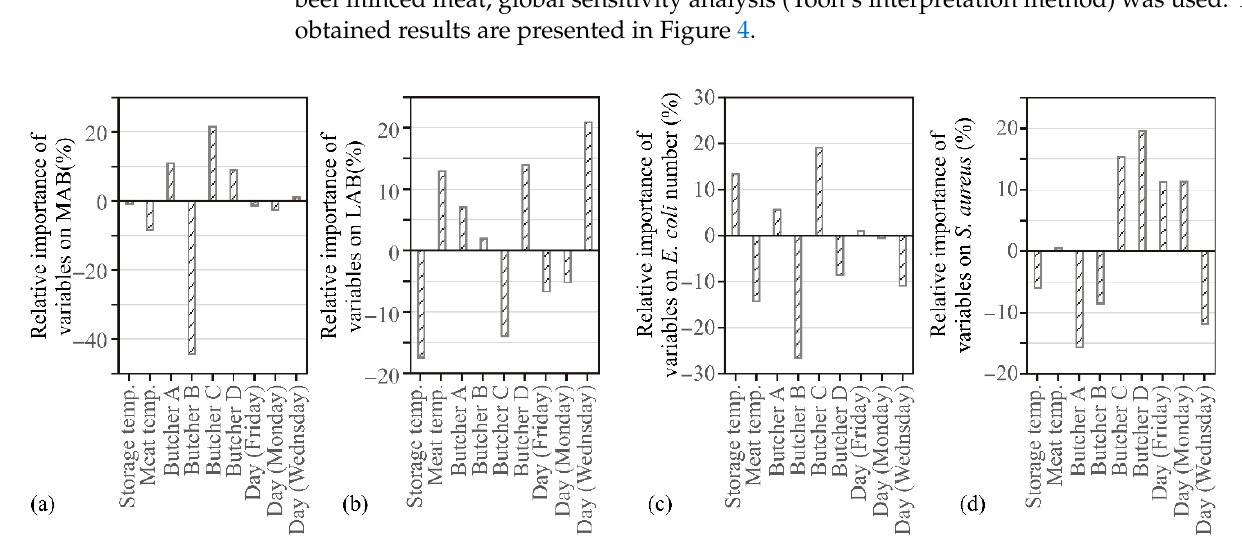
Figure 4. The relative importance of the input variables determined by the Yoon